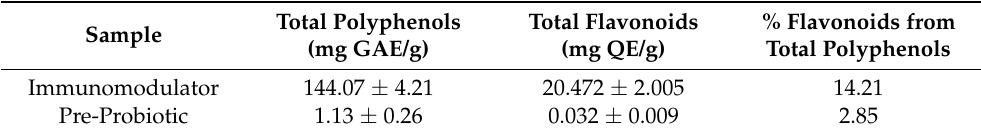
Table 1. Total content of polyphenols and flavonoids expressed as mg GAE/g sample and mg QE/g sample,